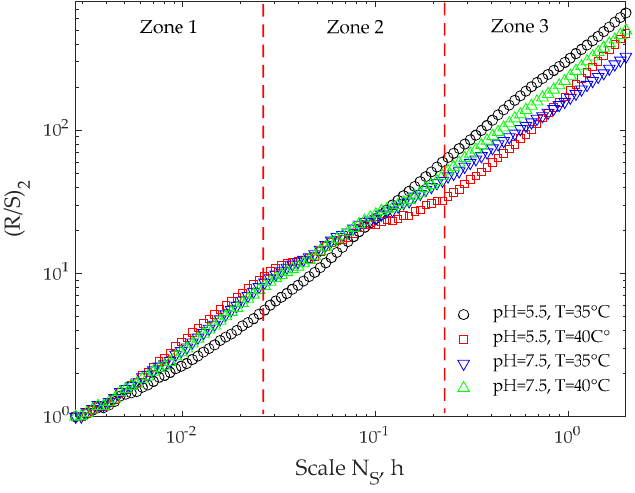
Figure 4. R / S statistic vs. time scale N S .